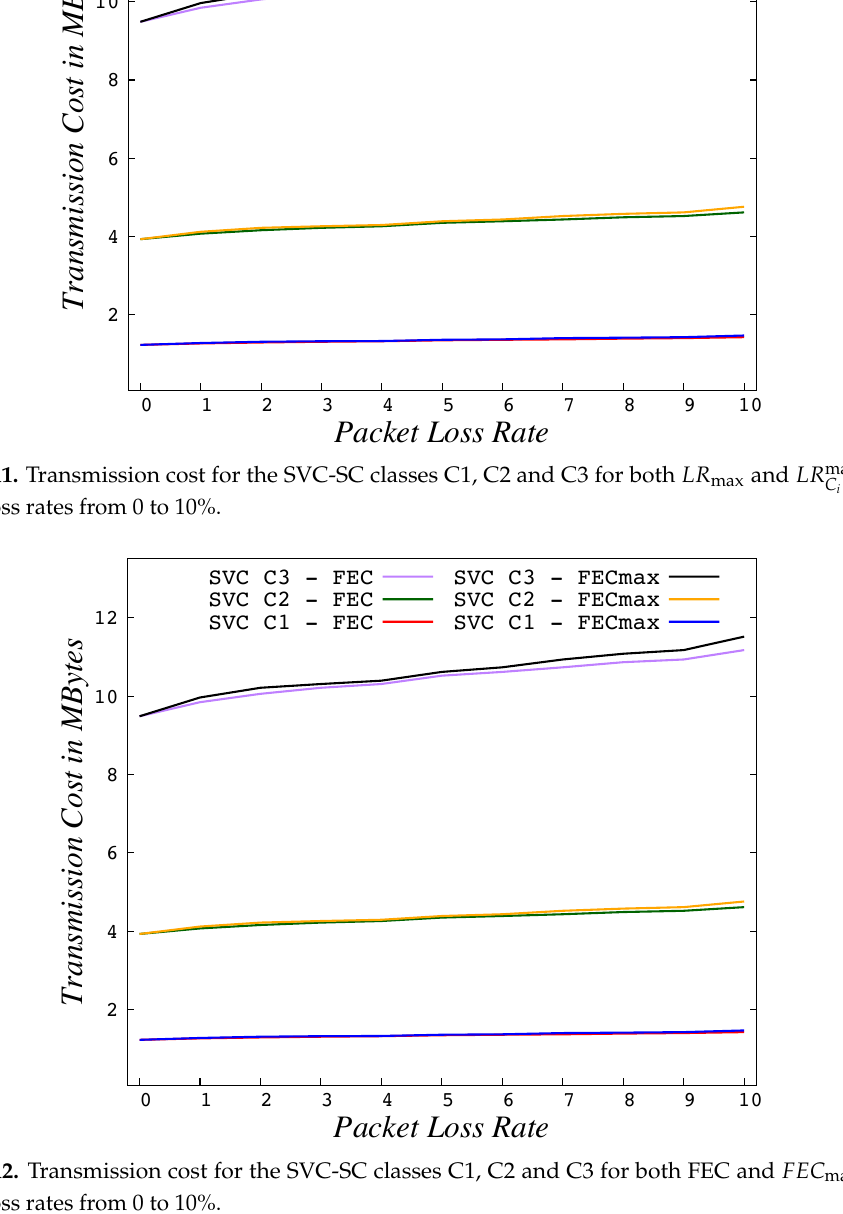
Figure A2. Transmission cost for the SVC-SC classes C1, C2 and C3 for both FEC and FEC max with packet loss rates from 0 to